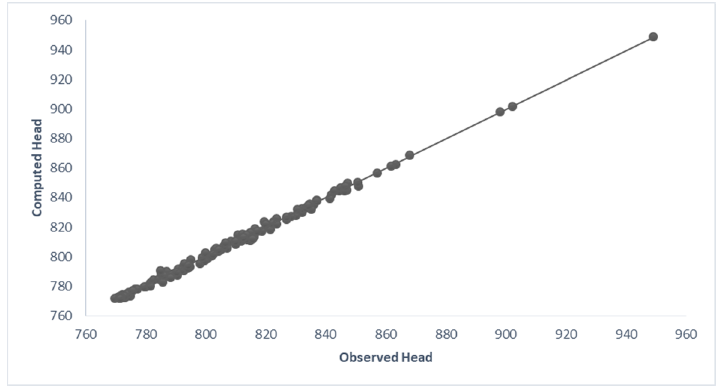
Figure 9. Comparison of computed and observed piezometric heads after the calibration of the steady-state groundwater flow model.